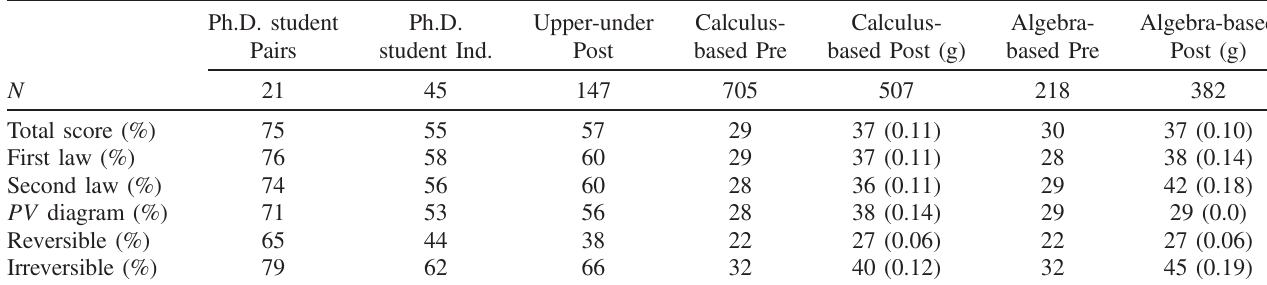
TABLE III. The average performance of different groups on all of the 33 items taken together or a subset of items and the number ( N ) of students who participated in the survey in each group. Upper-under consists of advanced undergraduate students who had learned the relevant concepts in an upper-level thermodynamics and statistical mechanics course, Ph.D. student Ind. (where ind. stands for individual) consists of entering physics Ph.D. students in their first semester of the Ph.D. program. Ph.D. student pairs consist of small groups (20 pairs and one group with 3) of Ph.D. students discussing and responding to the survey together. Pretest (pre) was administered at the beginning of the course and post-test (post) was administered at the end of the course in the introductory physics courses. The normalized gain, g , is listed for introductory courses for which both pre and postdata are available. Instructors ’ data are not shown here, as those data cannot be considered in a statistical manner. Four instructors self-reported that they performed near perfect, missing zero to two